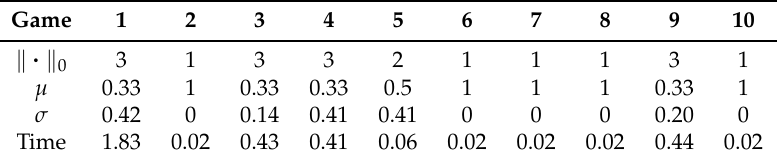
Table legend: Game—Tested 10 games; (cid:107) · (cid:107) 0 —The number of positive components in the sparsest equilibrium; µ —The average value of positive components; σ —The standard deviation of the positive components; Time—Time in seconds spent to obtain the sparest